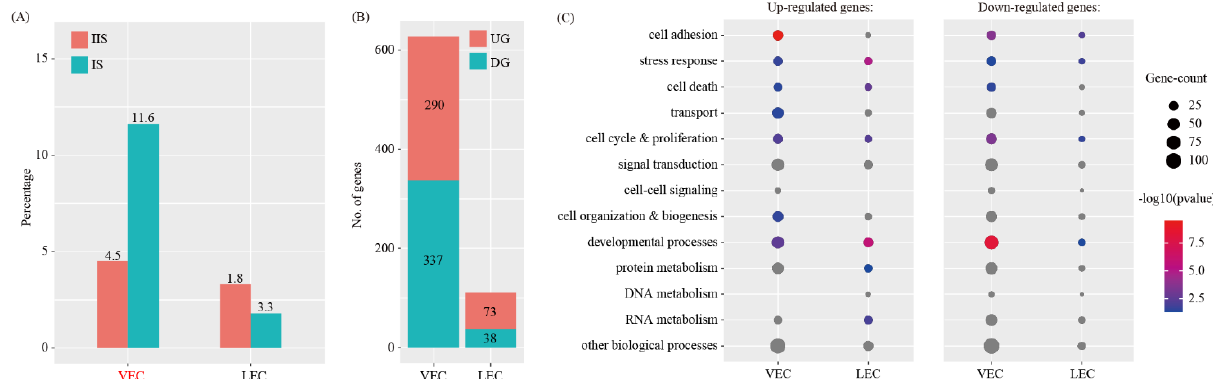
Figure 6. Identification of differentially expressed genes in endothelial cell during decidualization. ( A ) Bar plot showing the cell population change of 2 major endothelial cell types (VEC and LEC) at IS compared to IIS. Cell types with FC > 2 and p < 0.05 using χ 2 test were labeled in red. ( B ) Bar plot showing the count of differentially expressed genes in each immune cell type. The threshold values for differentially expressed genes were logFC > 0.25 and p < 0.05. UG, up-regulated gene; DG, down-regulated genes. ( C ) Gene ontology (GO) enrichment analysis of differentially expressed genes. Differentially expressed genes were grouped based on MGI GOslim terms under the biological process categories. Up-regulated genes and down-regulated genes were tested separately.